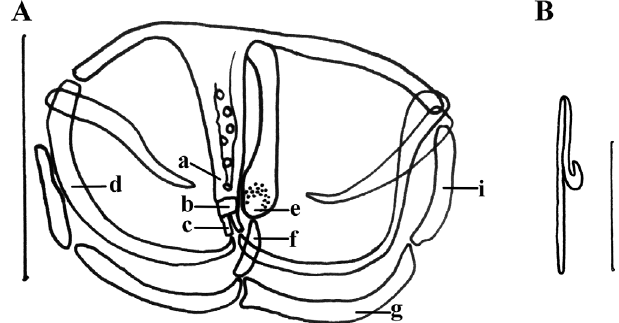
Figure 3. (A) Sclerites of posterior jaw divided into medial parts and lateral parts. (B) Point of the central hooks curls